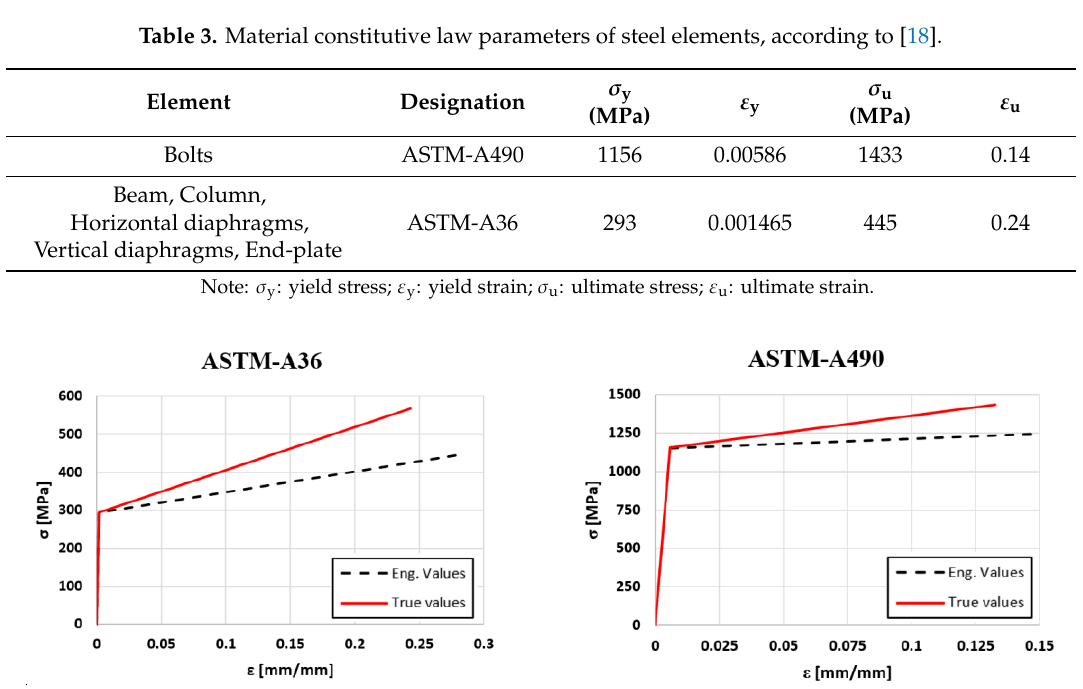
Figure 5. Simplified stress–strain relation of materials employed in FE models.